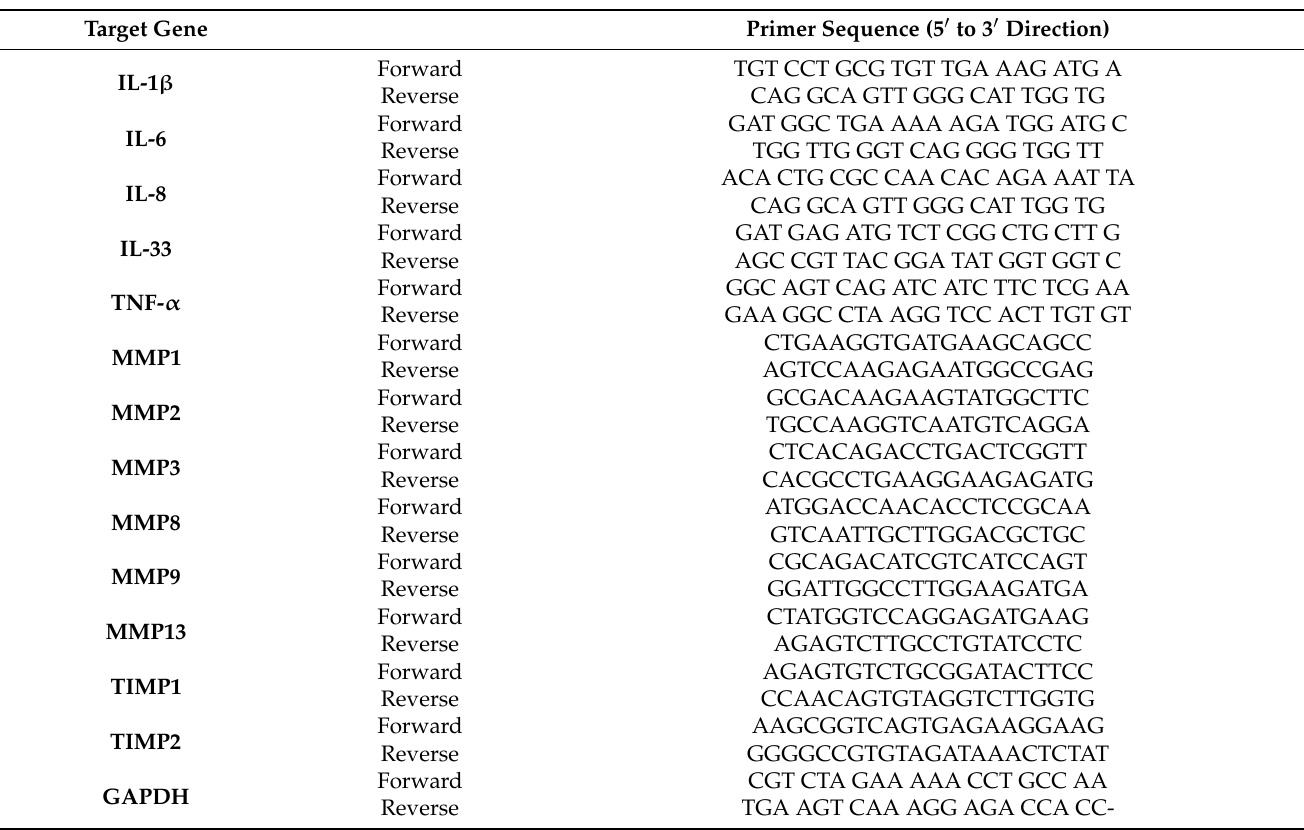
Table 2. Forward and reverse primer sequences for PCR